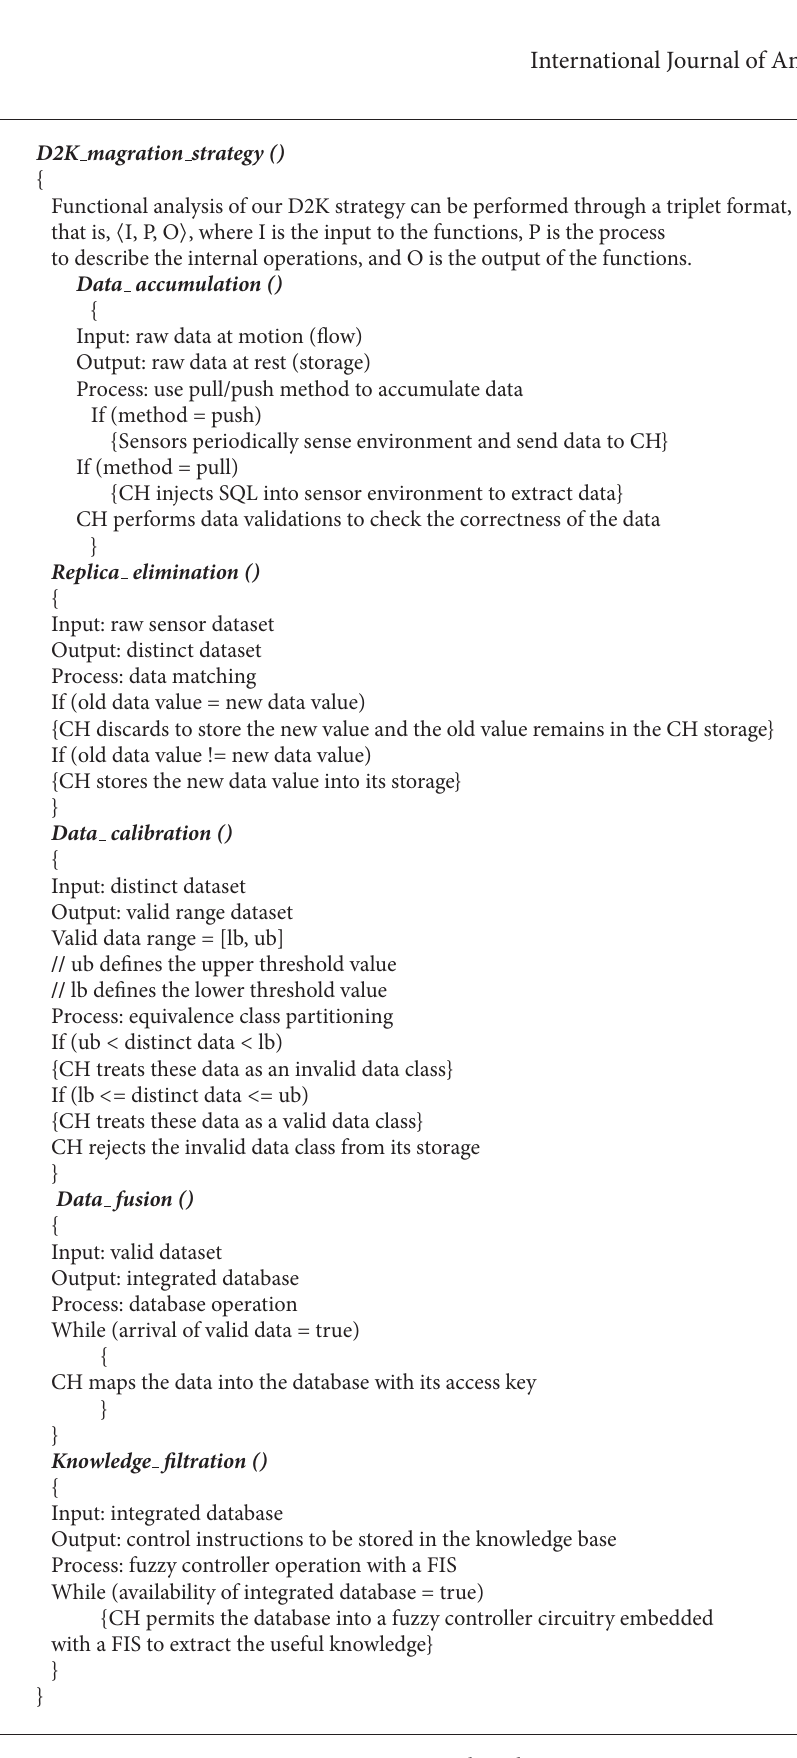
Algorithm 1: D2K